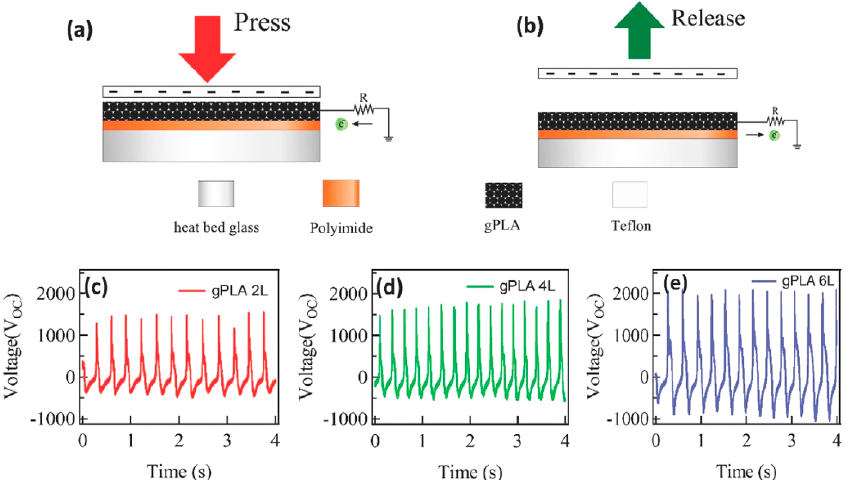
Figure 28. Wireless power transmission based on W-TENG (Wireless Triboelectric Nanogenerator). Equivalent-circuit model for the emission section ( a ), photographs of the transmitter ( b ), output current of 130.6 mA by the hybridized nanogenerator through two DC transformers with 5 V output ( c ), transmission distance of the WPT system: 40 cm ( d-i ) and 60 cm ( d-ii ) with a hand besides the receiver. Mobile phone charged by the WPT system with a distance 100 cm away from the transmitter ( e ). The output voltage through a voltage booster at a distance of 80 cm ( f ) [63].